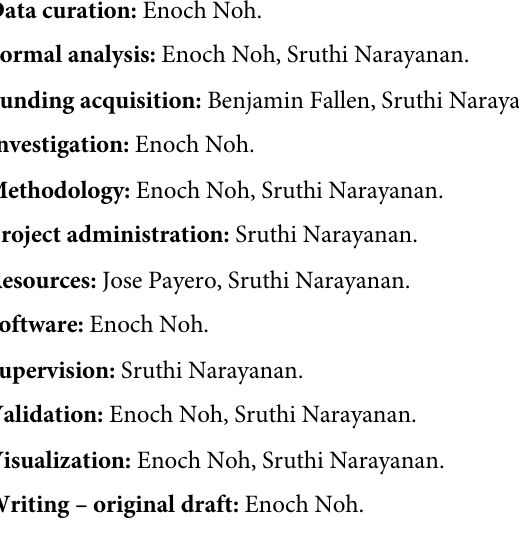
S1 Table. Details of field operation. S2 Table. Raw